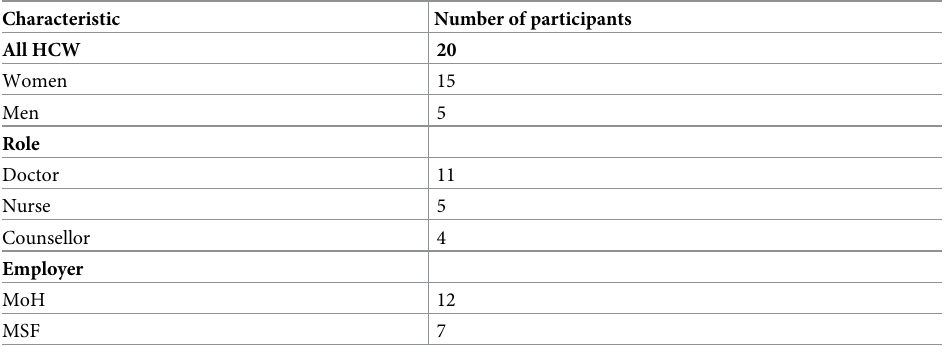
Table 2. Health-care worker (HCW) characteristics.